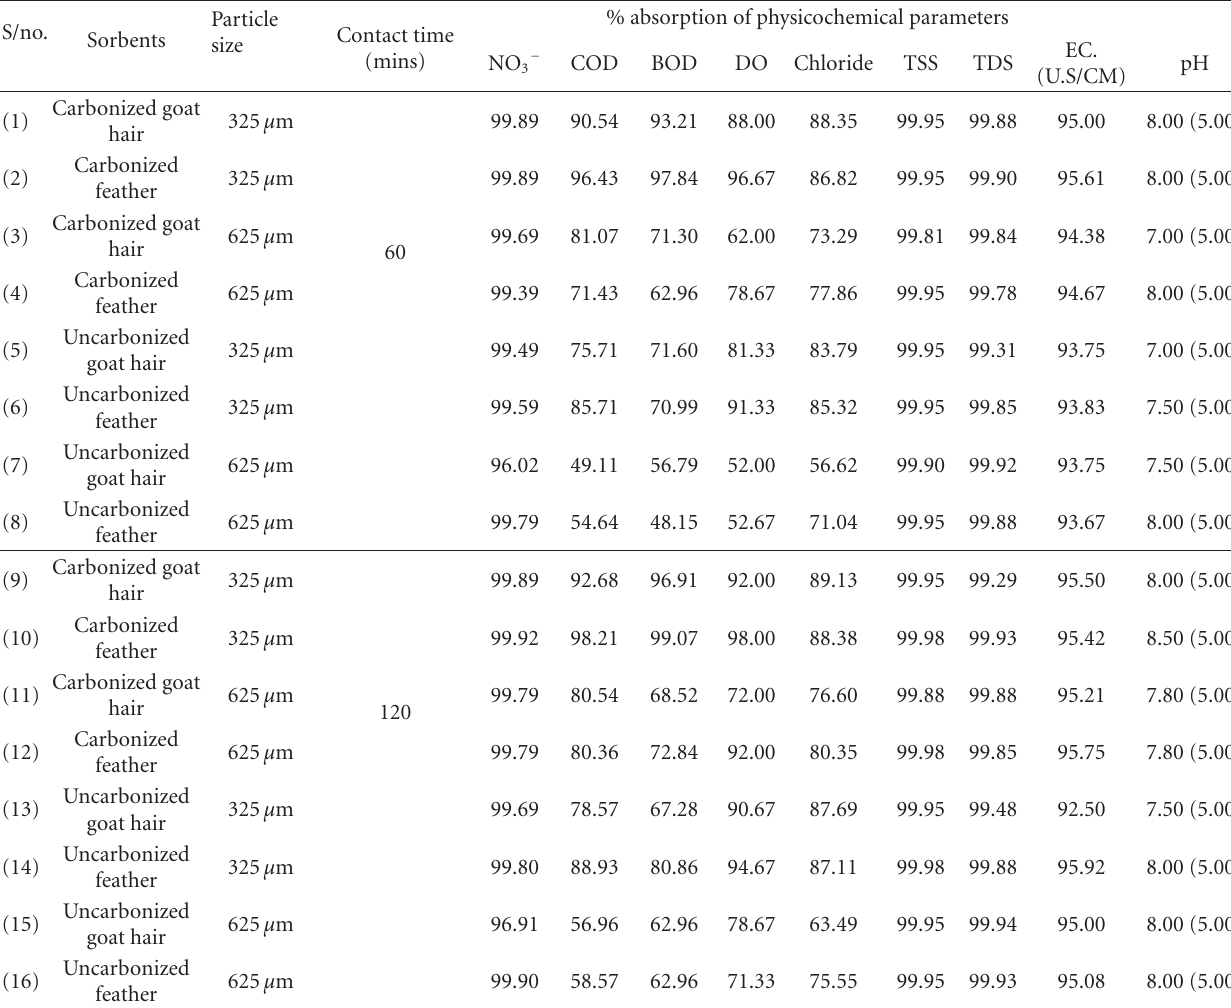
Table 1: Use of carbonized/uncarbonized waste protein sorbents in removal of pollutants from wastewater.